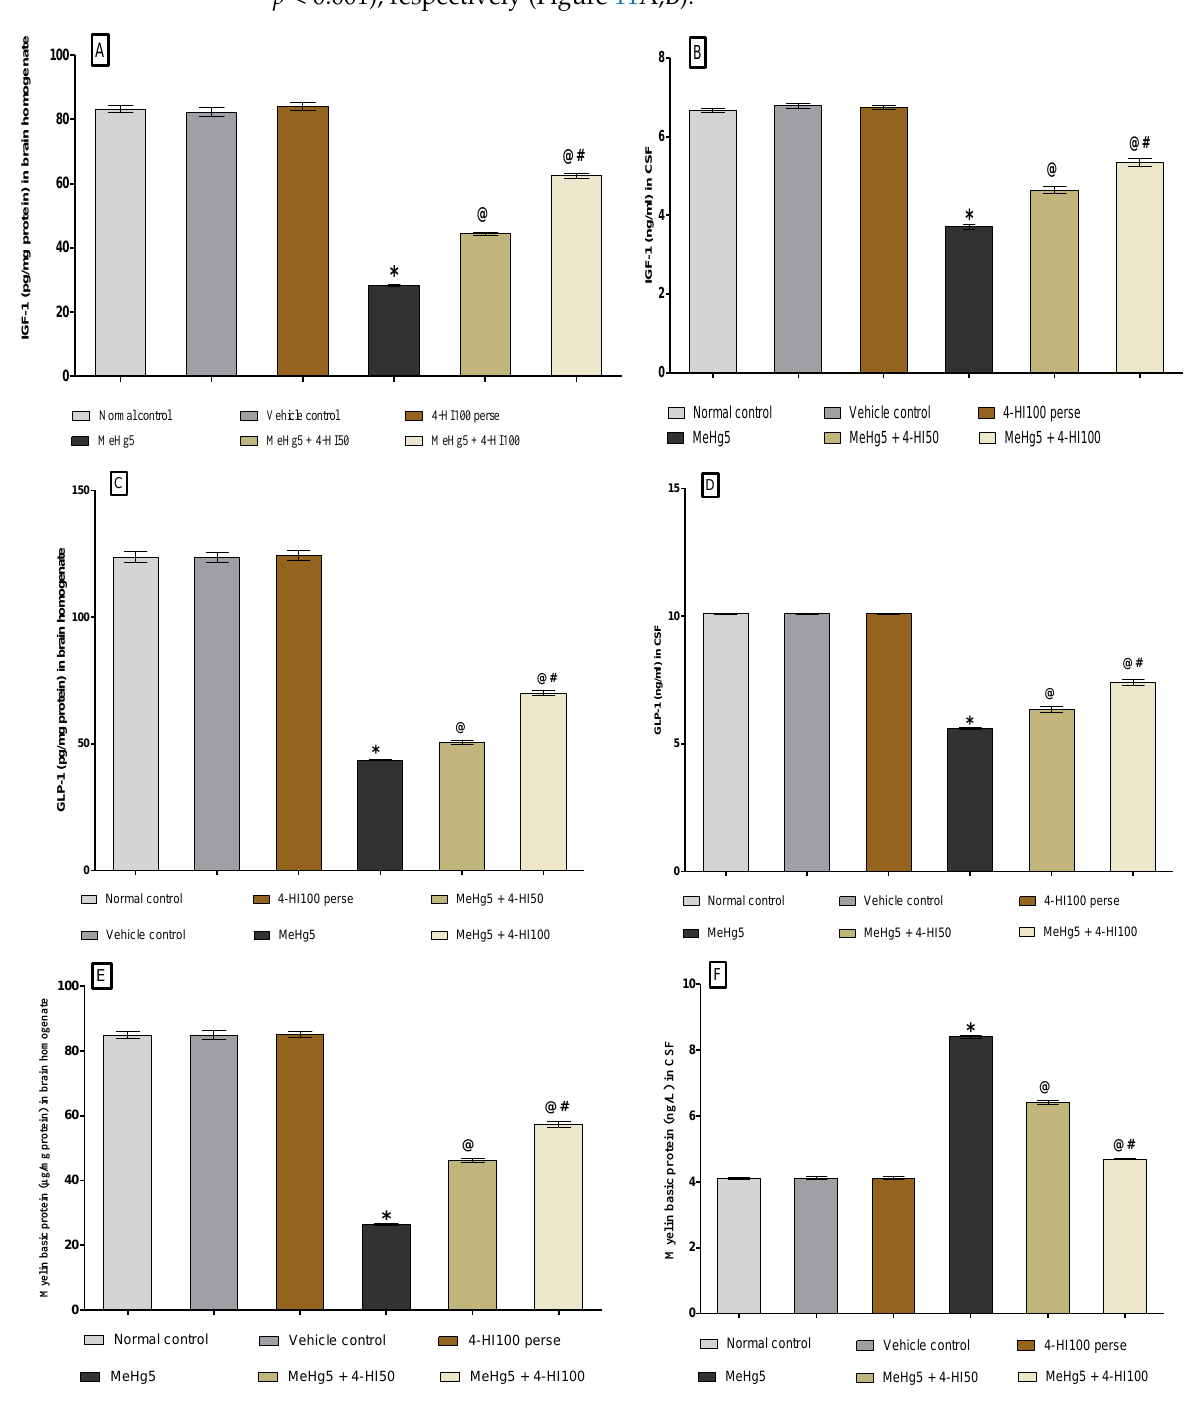
brain homogenate and blood plasma compared to normal control, vehicle control, and 4-HI- perse -treated groups. Chronic oral administration of 4-HI at doses of 50 mg/kg and 100 mg/kg substantially reduced the level of caspase-3 in brain homogenate (one-way ANOVA: F(5,25) = 0.9588, p < 0.001) and blood plasma (one-way ANOVA: F(5,25) = 0.5116, p < 0.001), respectively (Figure 11A,B).